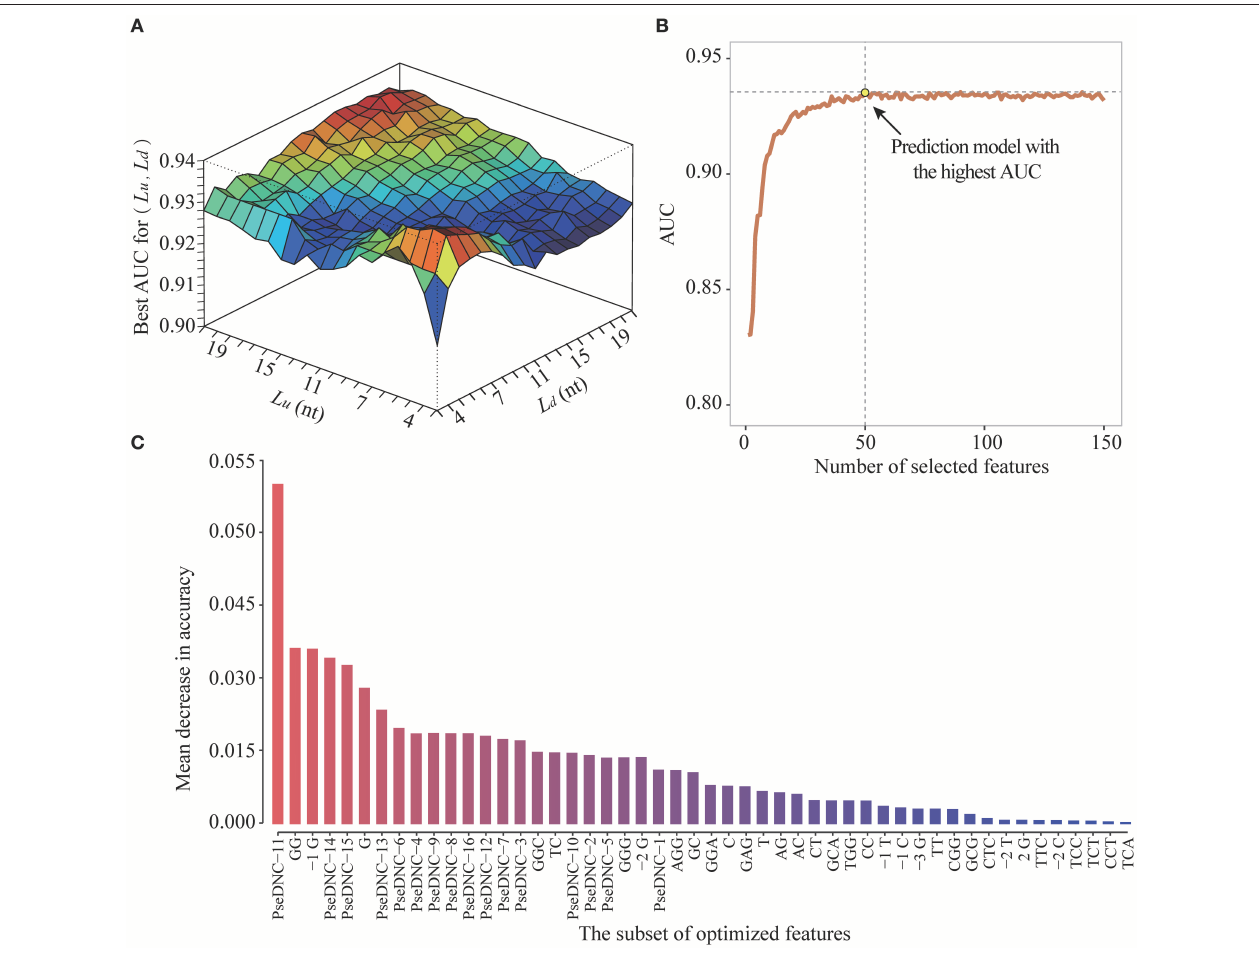
FIGURE 5 | The performance improvement of PEA-m5C using a hybrid optimization strategy. (A) The prediction performance of PEA-m5C in terms of AUC is optimized by varying window size and feature number. (B) The prediction performance of PEA-m5C in terms of AUC is optimized with different number of features for a given window size. (C) The top 50-ranked features used in the optimized prediction models of